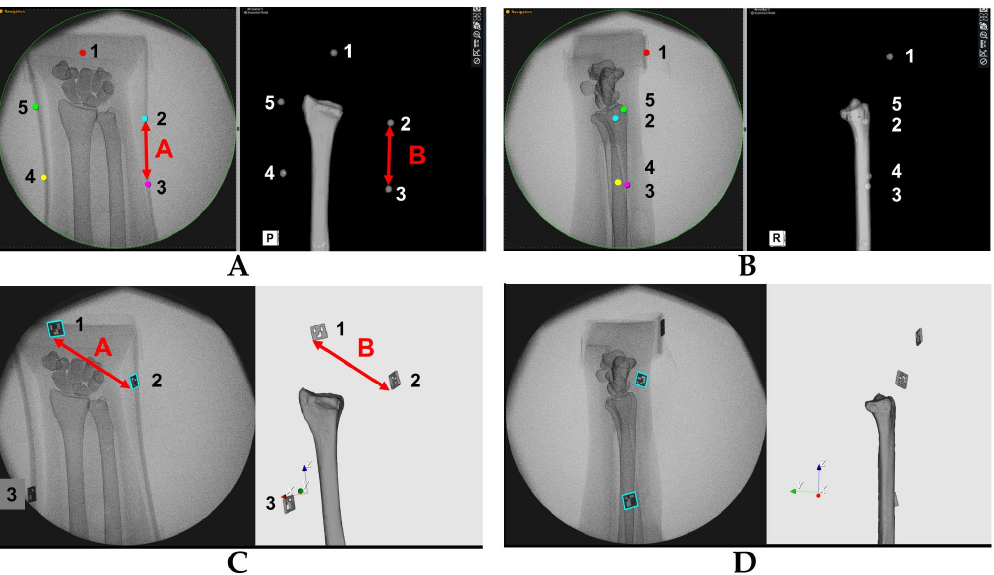
Figure 3. Evaluations of the tracking accuracy. Example images of the tracking. ( A ) Anterior–posterior view and ( B ) ulnar side lateral view with metal sphere markers, and ( C ) anterior–posterior and ( D ) ulnar side lateral view with QR code markers. A and B in the fi gures show the distance between markers for the fl uoroscopic and 3D images. The numbers in the fi gures indicate the marker number. Accuracies were evaluated by comparing the distance between markers on the fl uoroscopic and 3D images, which were projected on the monitor.